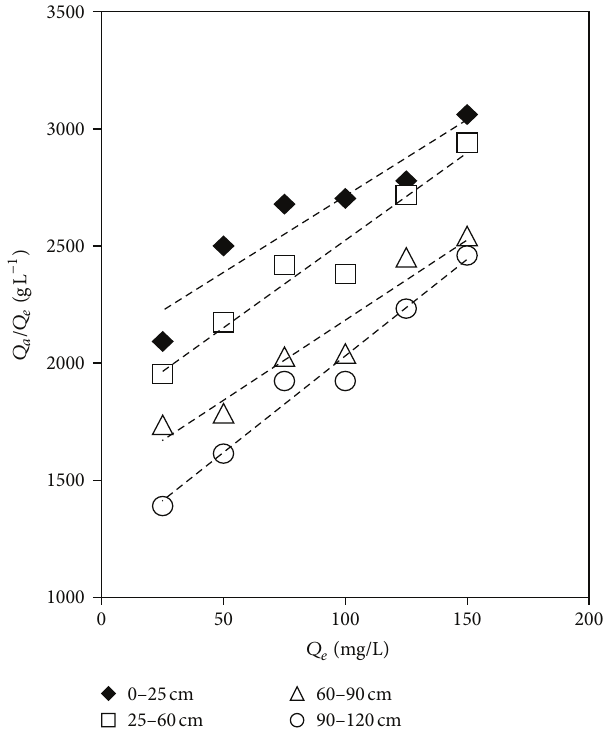
Figure 5: Freundlich isotherms for NO 3− sorption by soil profile at (25, 50, 75, 100, 125, and 150 mg NO 3− L −1 , 22 ∘ C, 24h, and soil mass =